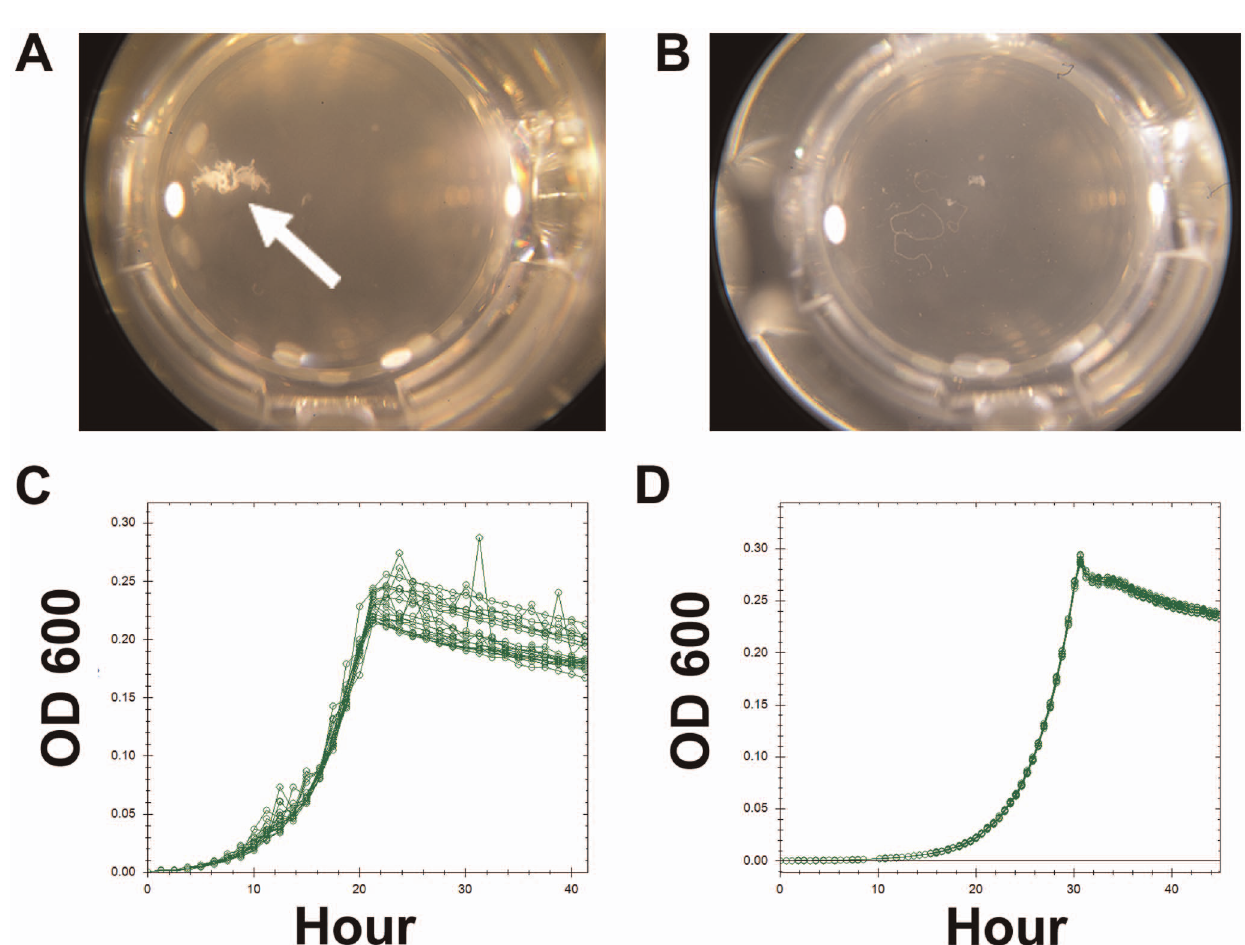
Figure 1. A comparison of the growth characteristics of M.extorquens with and without the cellulose genes removed. The top row shows pictures of individual wells after growth with (A) or without (B) the cellulose genes. A large clump of the wild-type strain is indicated by the white arrow. Such clumps were not found for AM1 D cel , but occasionally small strands such as those shown in B can appear. The bottom row (C and D) shows example growth curves obtained for 12 replicates with or without the cellulose locus. The OD readings of wild-type were noisy and irregular (C), whereas the AM1 D cel growth dynamics were more consistent (D). doi:10.1371/journal.pone.0062957.g001 PLOS ONE |